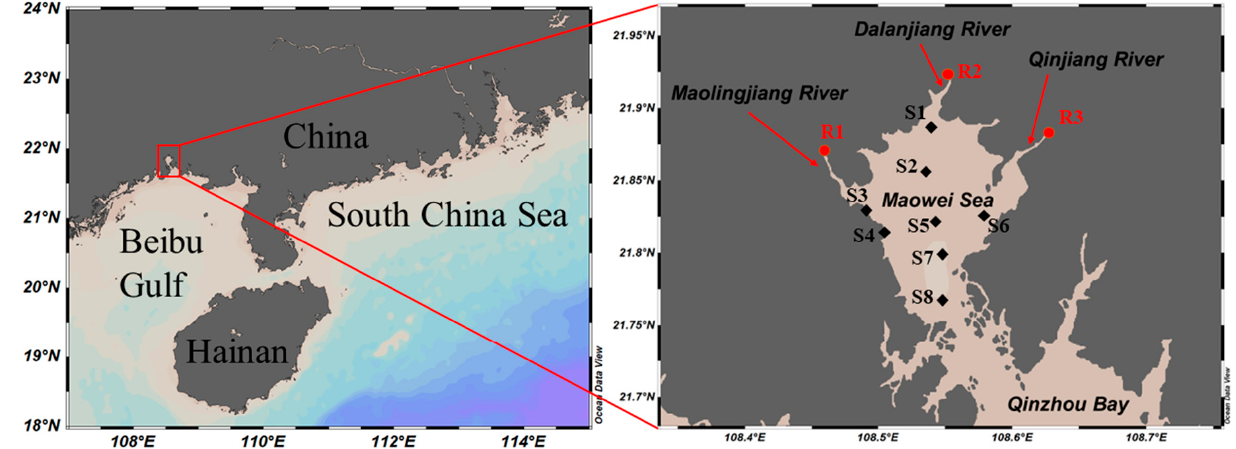
Figure 1. Geographical locations of the Maowei Sea and monitoring stations.